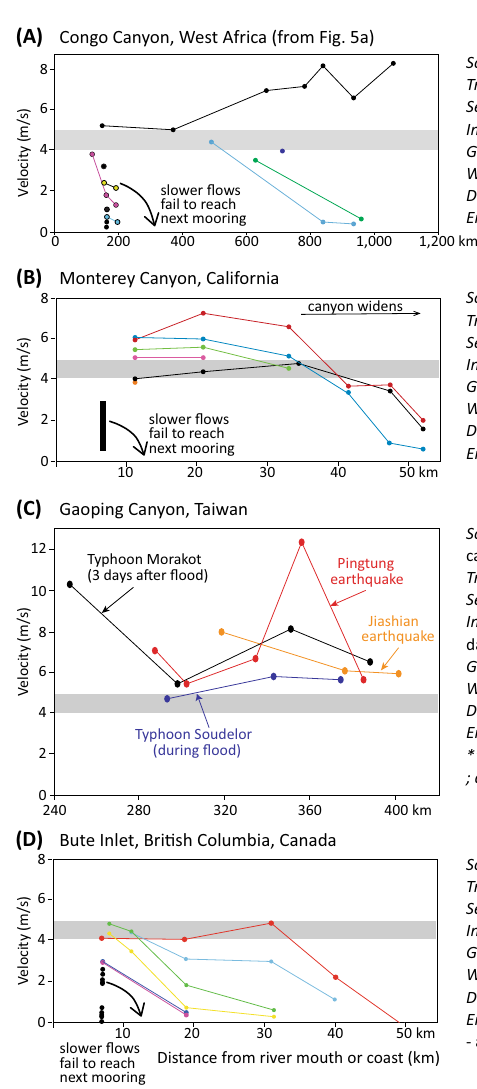
Fig. 7 Changes in turbidity current front velocity with distance for fl ows that are con fi ned in canyon and channels, from the four locations worldwide where such data are available. The threshold fl ow-front velocity (4 – 5 m/s) needed for ignition or autosuspension (grey rectangle) is similar in each system, despite major differences in grain sizes, sediment input, triggers and other parameters. These fi eld sites are A the Congo Canyon-Channel (this study), B Monterey Canyon offshore California 34,35 , C Gaoping Canyon offshore Taiwan 24,25 , and D Bute Inlet in British Columbia, Canada 58,59 . Data from individual fl ows are shown by different coloured lines and dots. Front velocities are averages between moorings or cable-breaks, and distances are measured from the coast or main river mouth. Speeds from Monterey Canyon also include maximum (internal) fl ow speed measured by ADCPs at the closest mooring to shore (black rectangle) 34,35 . Further information is provided for each system on the source and amount of sediment supplied, fraction of sand and mud, how fl ows are triggered, changes in seabed gradient and canyon-channel width, and annual volumes or depths of seabed erosion/deposition caused by these turbidity currents (see Supplementary Discussion for more details and references on which fi gure is